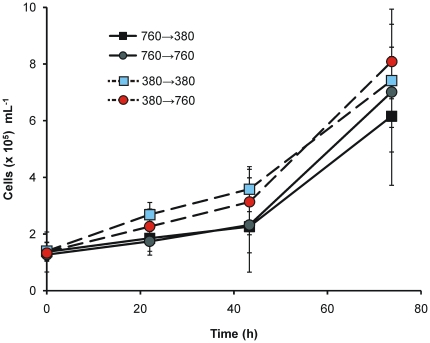
Response in batch culture of T. pseudonana cells from long-term, pH auxostat continuous cultures on transfer to different pCO2.Cells from all 6 long-term cultures each inoculated into batch cultures aerated at 760 µatm pCO2 or 380 µatm pCO2. For example, 760→760 represents cells from the long-term culture grown at 760 µatm pCO2 inoculated into a batch culture equilibrated with 760 µatm CO2. 760→380 represents the same cells (from 760 µatm CO2 continuous culture) inoculated into a batch culture equilibrated with 380 µatm CO2. Mean values (±2SE) of triplicate batch cultures from each inoculum.